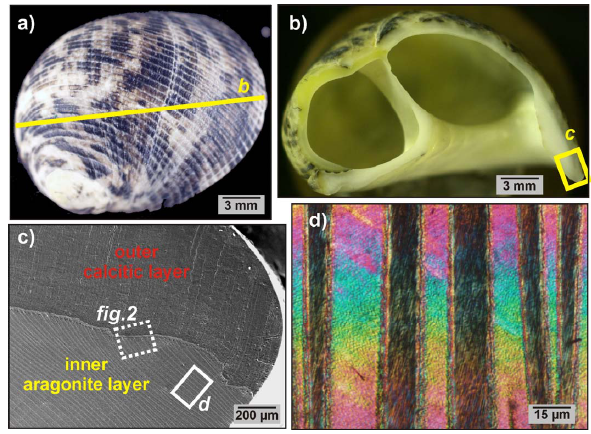
Fig. 1. a) Picture showing the shell of Nerita undata . Line indicates where the specimen was cut. b) Cross section of the shell along radial axis (the square labeled “c” indicates the area shown in Fig. 1c). c) SEM micrograph of a section across the outer lip close to the aperture of the shell. The dotted-square indicates the approximate orientation of the scans of Fig. 2b-e, 3a-f, and 4b-c, and the plain square the orientation of 1d. d) Thin section of the aragonitic crossed lamellar structure forming the inner layer of the shell observed using polarized light microscopy (with crossed polars).